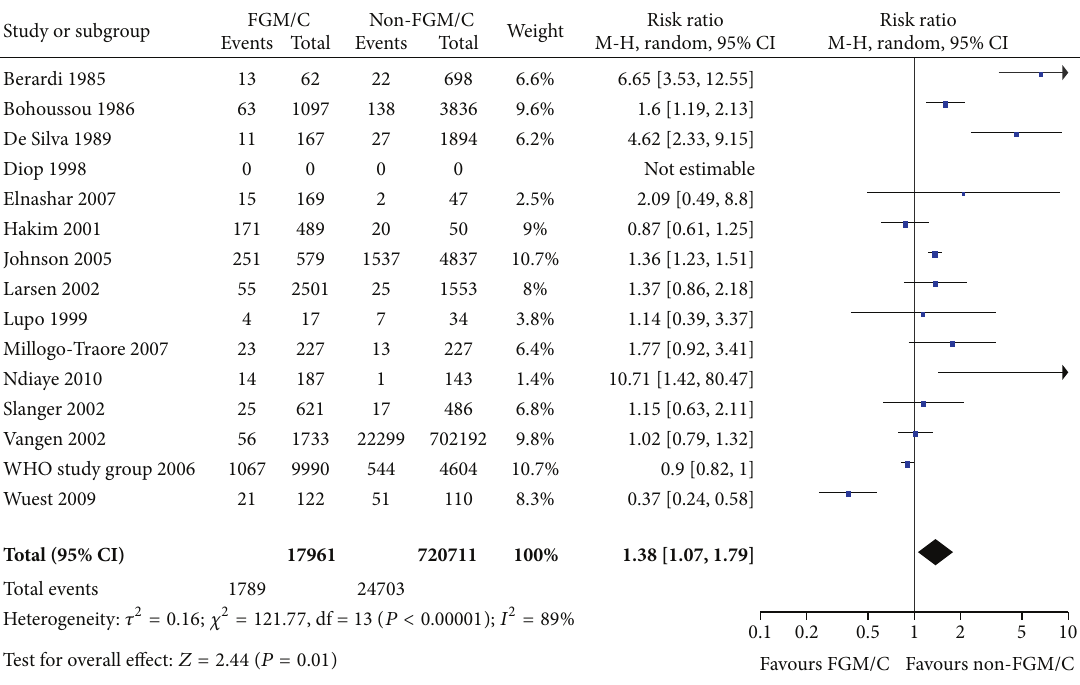
Heterogeneity: 𝜏 2 = 0.16 ; 𝜒 2 = 121.77 , df = 13 ( P < 0.00001 ); I 2 = 89 % Test for overall effect: Z = 2.44 ( P = 0.01 ) Figure 3: Forest plot, obstetric tears/lacerations. Note: Sensitivity analyses for outcome (degree of tears) and study type were not statistically significant. Data were missing in Diop et al. [34], and we did not succeed in obtaining data from the authors; thus, results from this study are not estimable. WHO study group [19]: unpublished data.